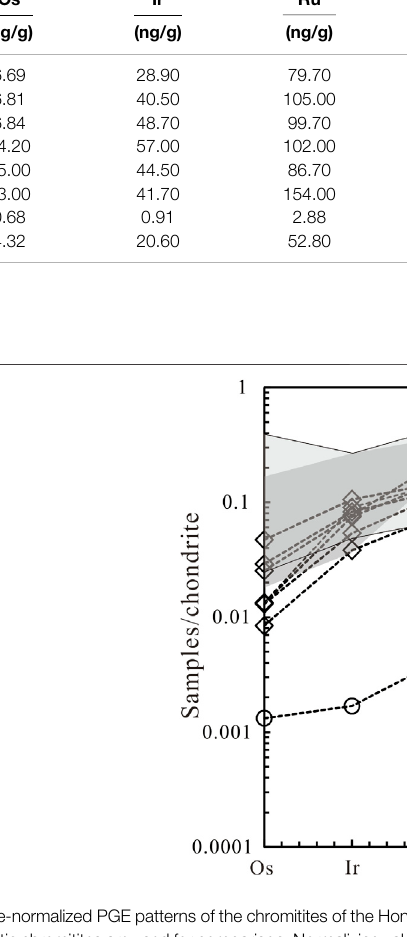
TABLE 1 | PGE compositions of whole-rock samples of chromite-bearing dunites in Hongshishan complex. Sample